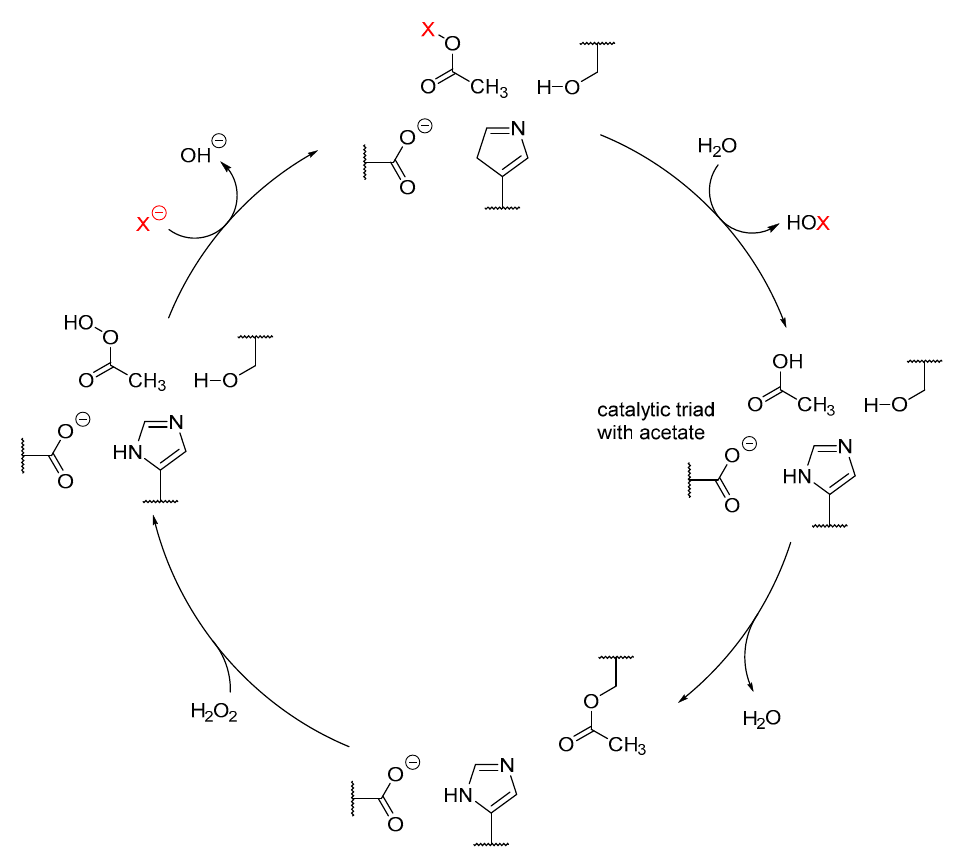
Figure 12. Proposed catalytic cycle of metal-free haloperoxidases/perhydrolases. This mechanism was compiled from several sources [81,85]. The catalytic cycle is adopted from the common hydrolase catalysis encountered in lipases and esterases, for instance. In presence of a carboxylic acid, in this case acetic acid, an ester is formed with the catalytic serin residue upon elimination of water (3 ‘o clock). In presence of hydrogen peroxide, the ester is cleaved, forming a percarboxylic acid. In the following step, a halide binds to the peroxoacid, which is hydrolyzed to the hypohalous acid, while the characteristic Ser-His-Asp triad is already regenerated.